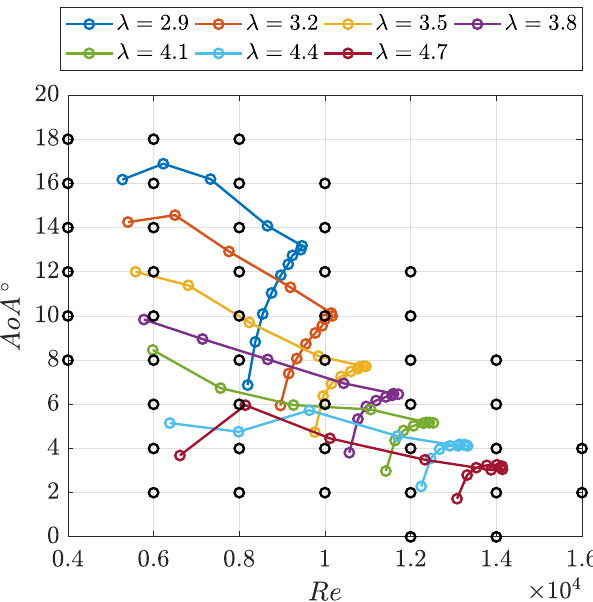
Figure 4. Reynolds number Re and angle of attack AoA experienced by the blade sections in the wind turbine for different tip-speed ratios λ around the optimal one. The black dots show the LES cases